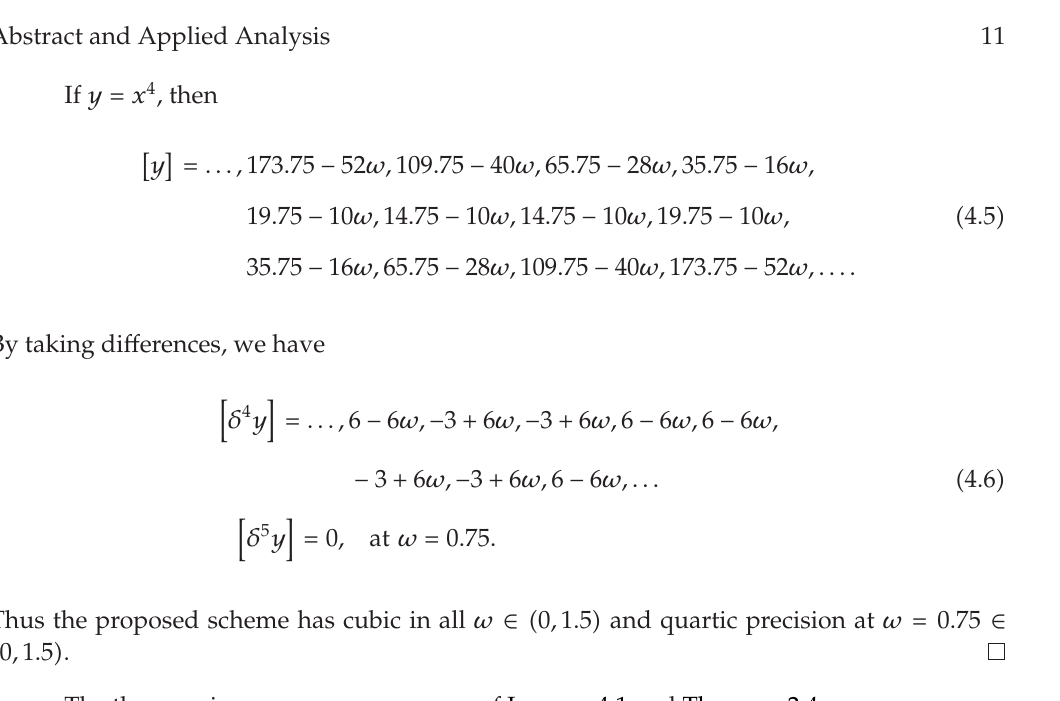
of proposed scheme. The following i